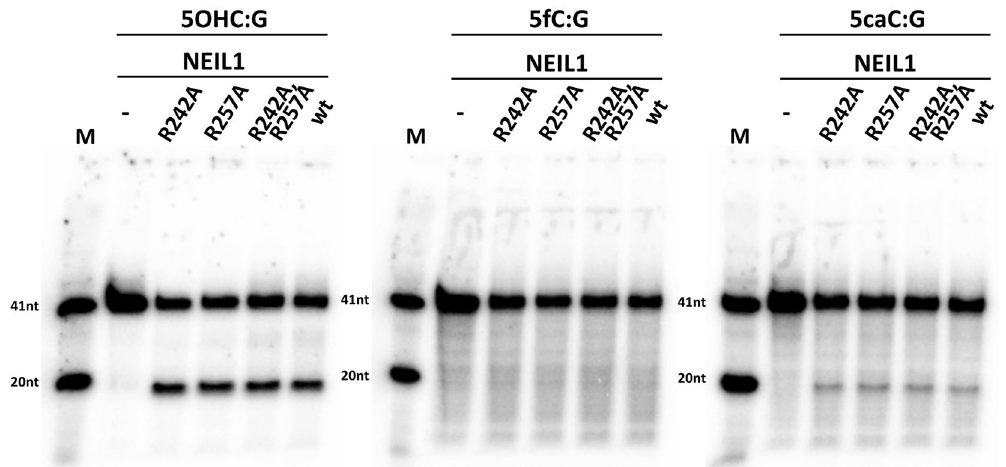
Figure 4. Pocket wall interactions are not required for NEIL1 activity against 5caC: The glycosylase activities of NEIL1 and of the indicated variants were tested by incubation with dsDNA substrates containing a 5OHC, 5fC or 5caC base ( 32 P radiolabelled in the modified strand). After 1 hour incubation of 20 nM dsDNA with 200 nM enzyme at 37 °C, the samples were treated with NaOH to induce single strand breaks at abasic sites. Cleavage products were analysed by denaturing gel electrophoresis and visualized by